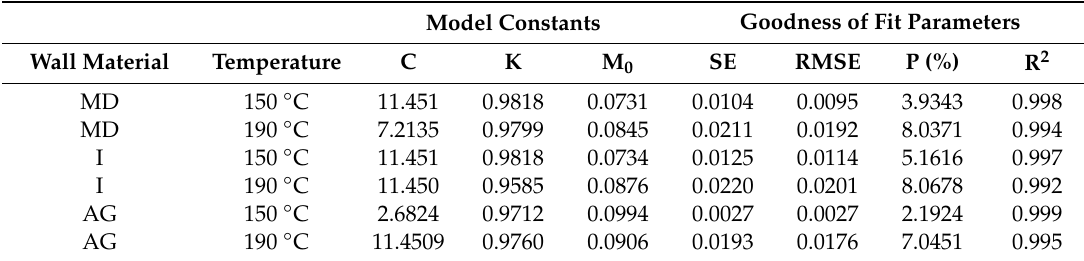
Table 3. Estimated GAB parameters for particles from pineapple peel extract encapsulated with maltodextrin (MD), inulin (I), and arabic gum (AG) as wall materials. Model constants (C and K), and mean absolute percentage error